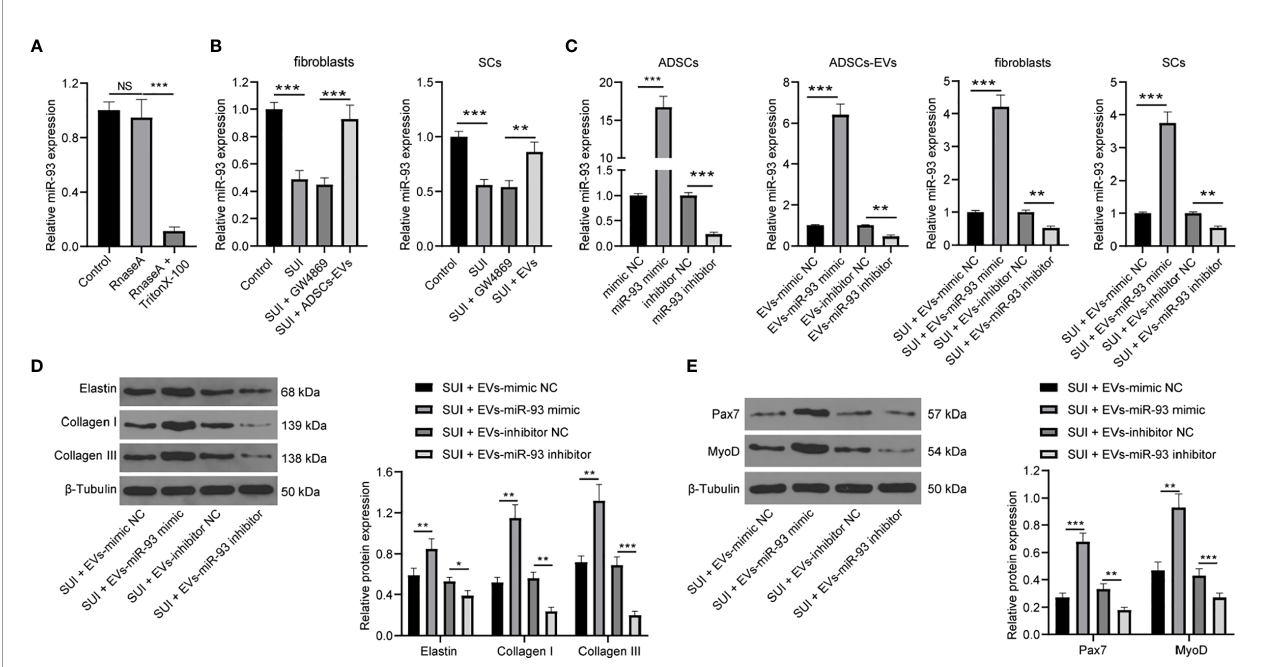
FIGURE 4 | ADSCs-EVs regulate fi broblasts ECM remodeling and SC activation through miR-93. (A) RT-qPCR for detecting miR-93 expression in culture medium after the addition of RNase A alone or the combination of RNase A and Triton X-100 to the culture medium of ADSCs. (B) RT-qPCR detection of miR-93 expression in fi broblasts and SCs. (C) RT-qPCR for detecting miR-93 expression after miR-93 mimic or inhibitor intervention (ADSCs were transfected with miR-93 mimic or inhibitor, and then the isolated EVs were utilized to act on SUI fi broblasts or SCs). (D) Western blot assay for determining the in fl uences of Elastin, Collagen I, and Collagen III protein expression in SUI primary fi broblasts in each group. (E) Western blot assay for determining the in fl uences of Pax7 and MyoD protein expression in SUI primary SCs in each group. U6 was used as the miR-93 reference gene in the RT-qPCR data, and 2 − DD Ct was used for quantitative analysis; the Western blot assay data was normalized to the background value and the control b -Tubulin band value. N = 3. The differences between two groups were analyzed by Student ’ s t − test (B – E) The differences among multiple groups were analyzed using one-way ANOVA and Tukey ’ s post hoc test (A) NS, not signi fi cant. * P < 0.05; ** P < 0.01; *** P <